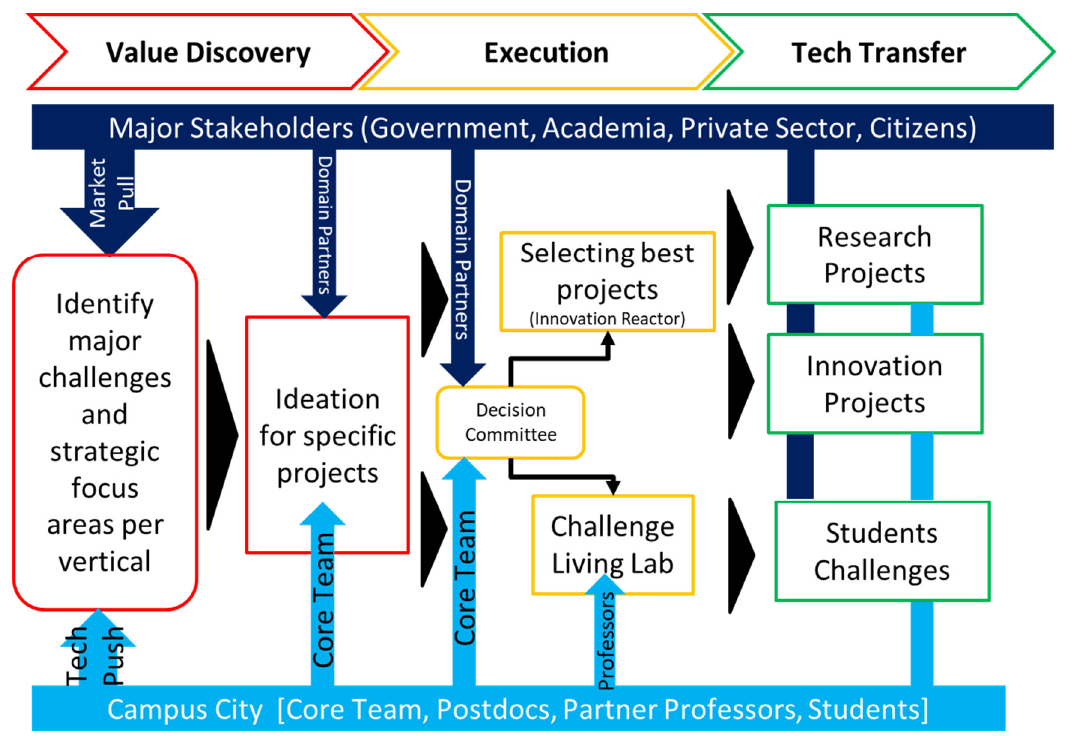
Figure 3. Campus City working model.